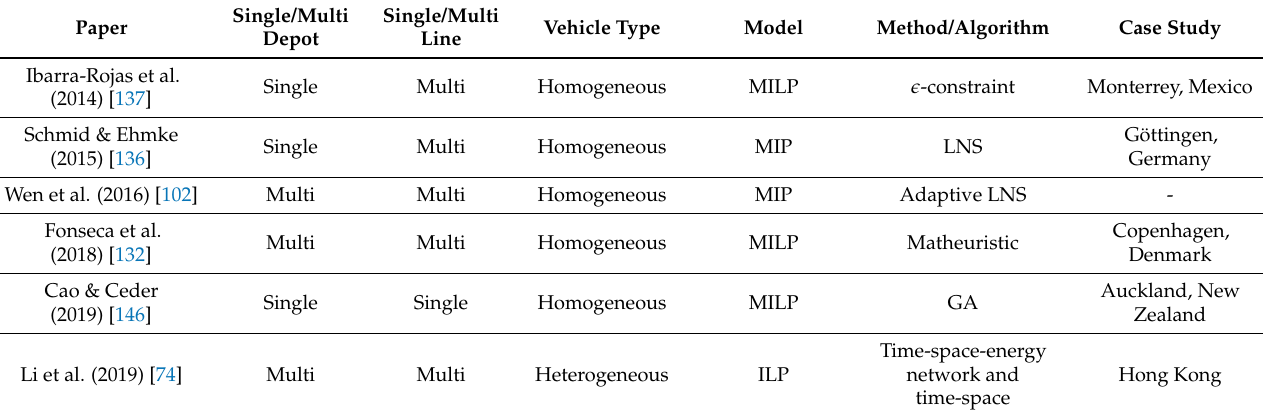
Table 7. The characteristics of electric bus scheduling, timetabling, and solution